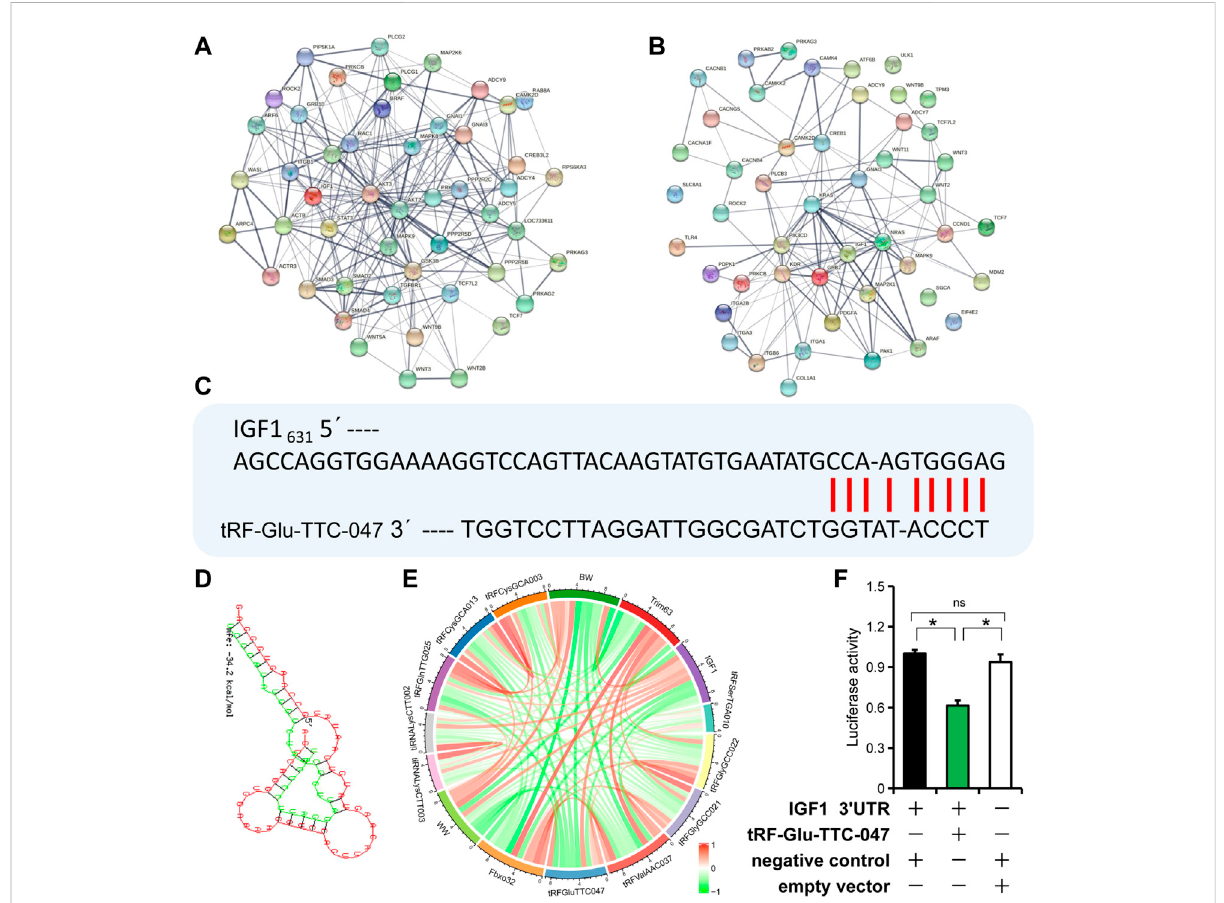
FIGURE 6 IGF1 is one of the target genes of tRF-Glu-TTC-047. (A) Interaction network of upregulated tRNA-derived small (tsRNAs) target genes in normal-size pigs. (B) Interaction network of upregulated tsRNAs target genes in intrauterine growth restriction (IUGR) pigs. (C) Sequence alignment of tRF-Glu-TTC-047 with the 3 ′ UTR of IGF1 . (D) Minimum free energy of tRF-Glu-TTC-047 and 3 ′ UTR of IGF1 was predicted using RNAhybrid. (E) Correlation of piglet body weight (birth weight and weaning weight) with expression levels of top ten differentially expressed tsRNAs, Fbxo32 , Trim63 ,and IGF1 . (F) Thedual-luciferasereportersystemshowedthebindingrelationshipoftRF-Glu-TTC-047tothe3'UTRofIGF1.n=3;*indicates statistical signi fi cance ( p <